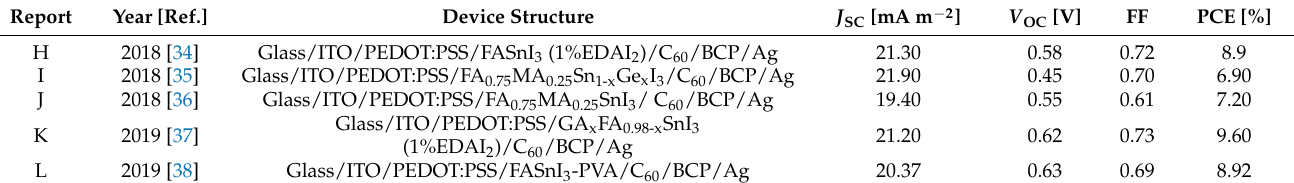
Table 5. Record table containing the reported Sn-PSCs and the corresponding photovoltaic parameters mentioned in Section 2.4.